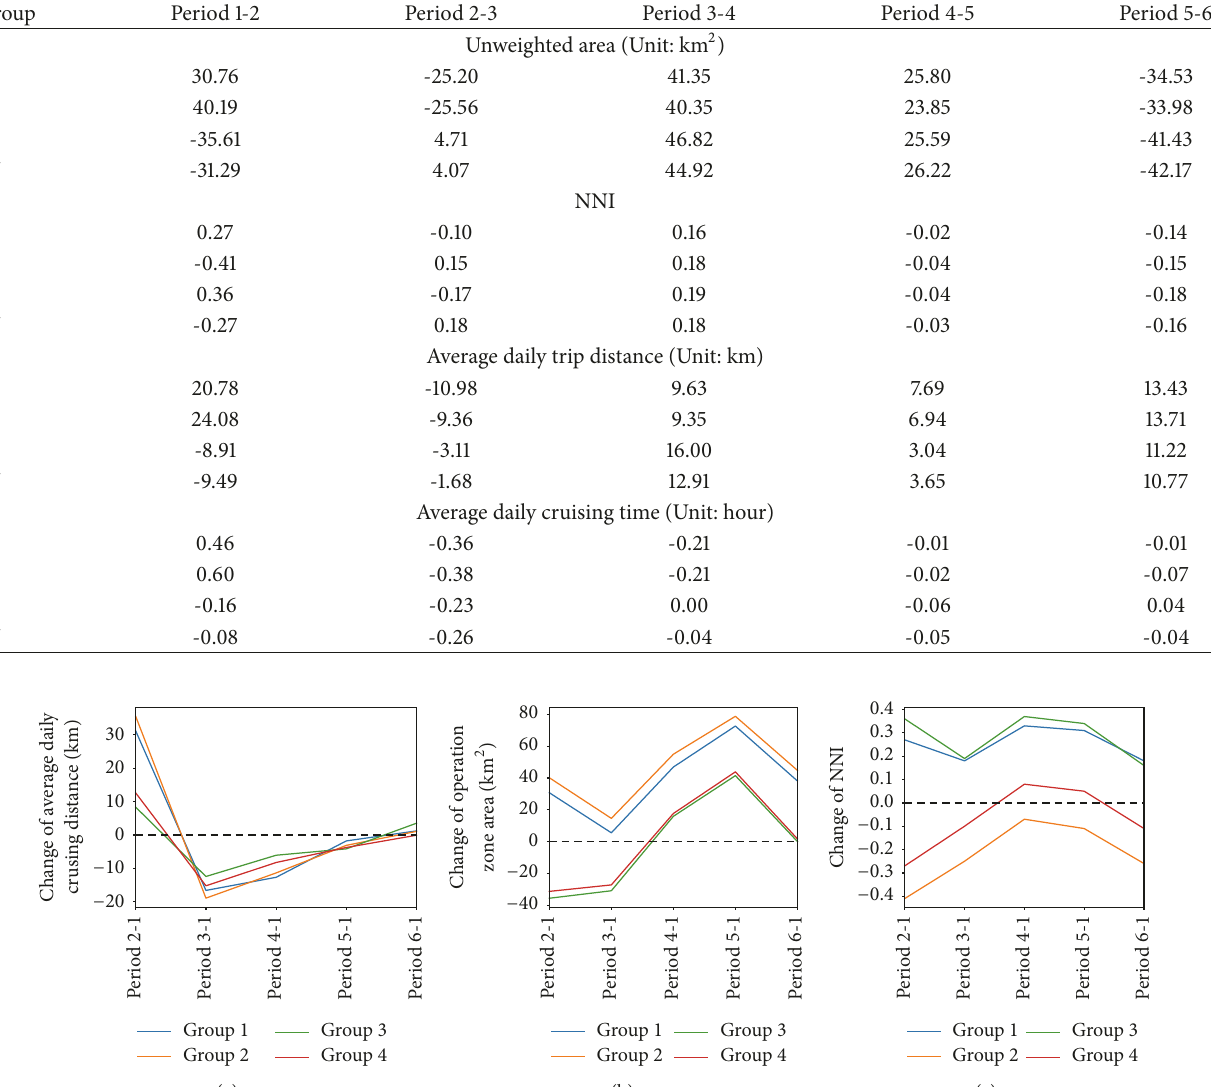
Table 4: The spatial changes in the operation zones, the changes in the average daily trip distance and the cruising time in each group between all of the neighboring periods.